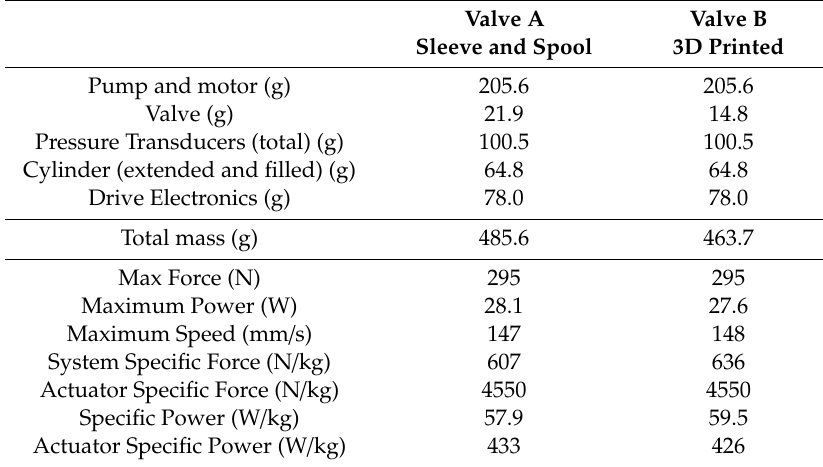
Table 5. Mini EHA component weights and specific force and power.